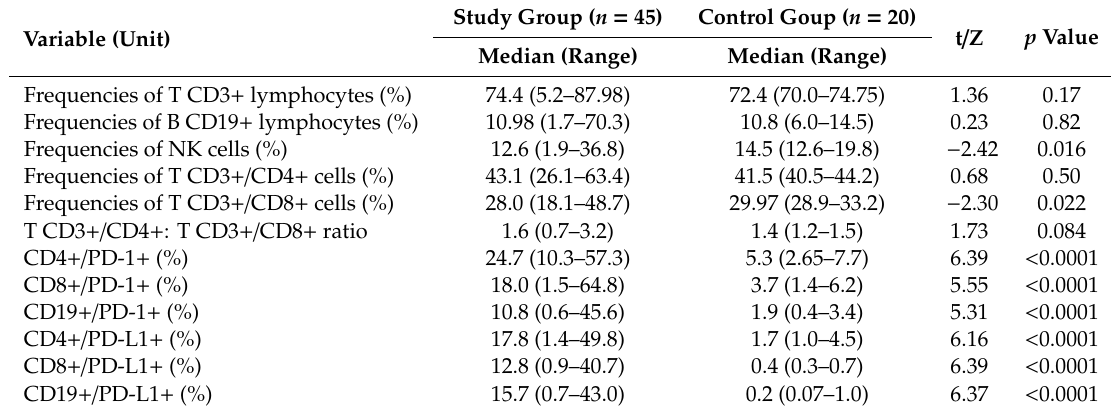
Table 3. Immunophenotyping of peripheral blood lymphocytes. Frequencies of subpopulations within the leukocyte (CD45 + ) population are shown.